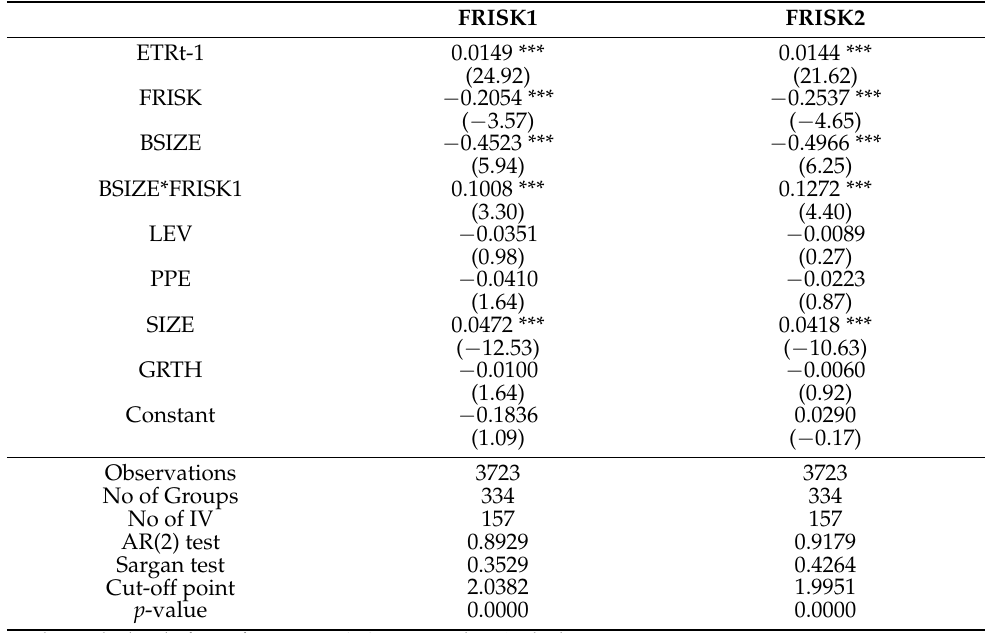
Table 9. The effect of Board Size on the relationship between firm risk and the level of tax